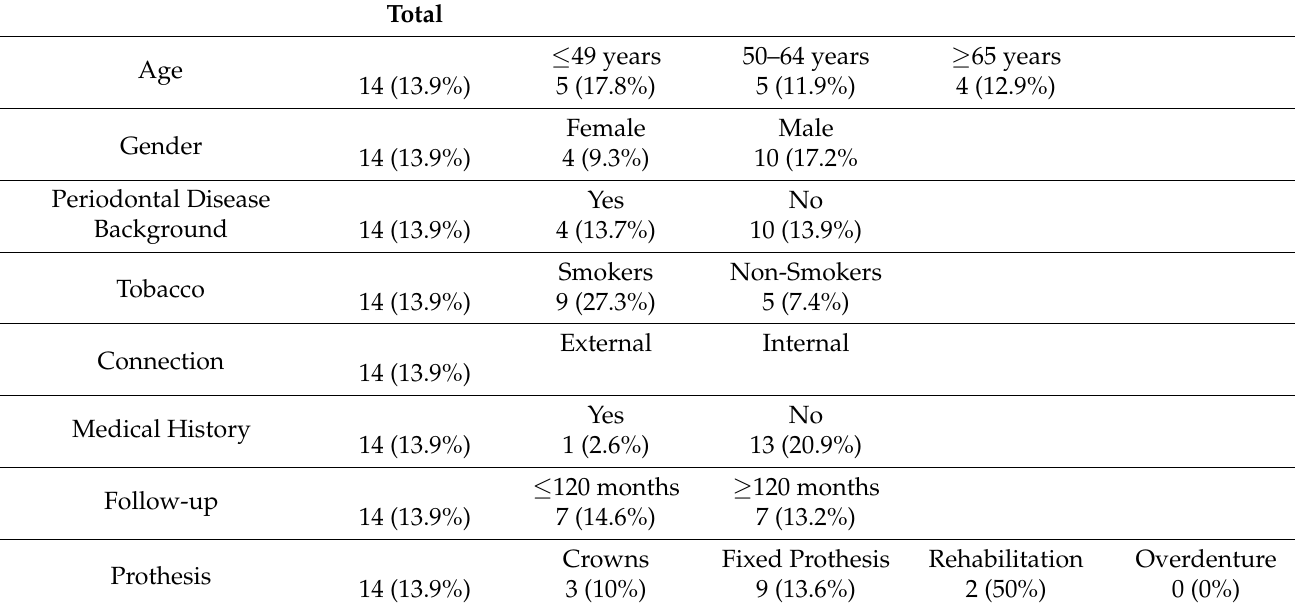
Table 5. Peri-implantitis